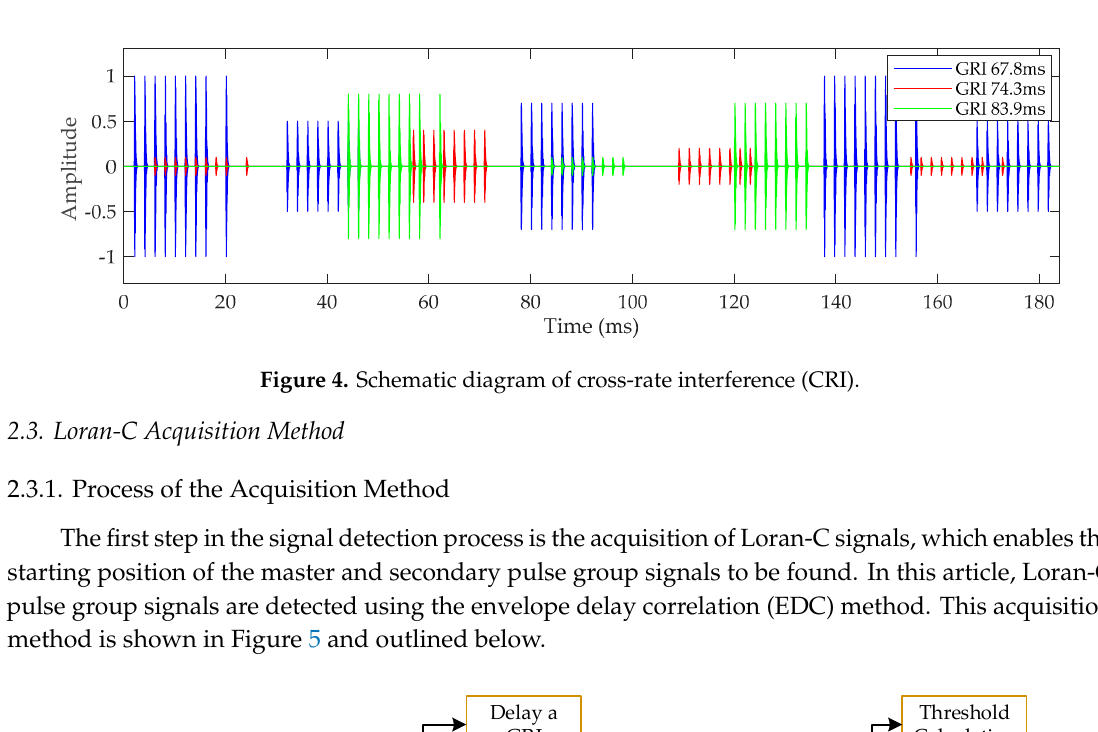
schematic diagram of CRI is shown in Figure 4. CRI signals will occur periodically, causing